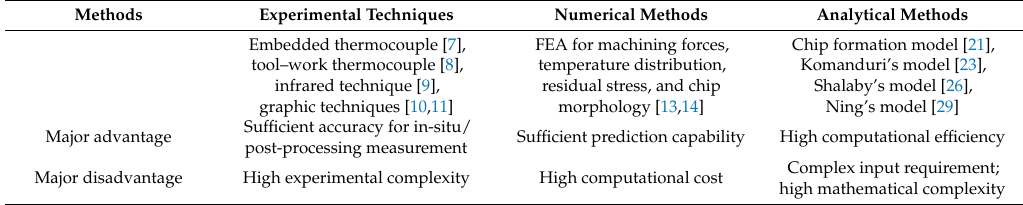
Table 1. Summary of experimental and modeling methods in the investigation of the machining process.